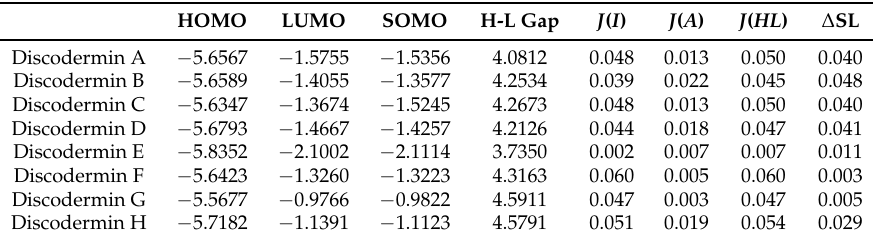
Table 3. HOMO, LUMO and SOMO orbital energies, HOMO-LUMO gap and the KID descriptors (all in eV) tested in the verification of the Koopmans-like behavior of the MN12SX density functional for the Discodermins A–H family of marine